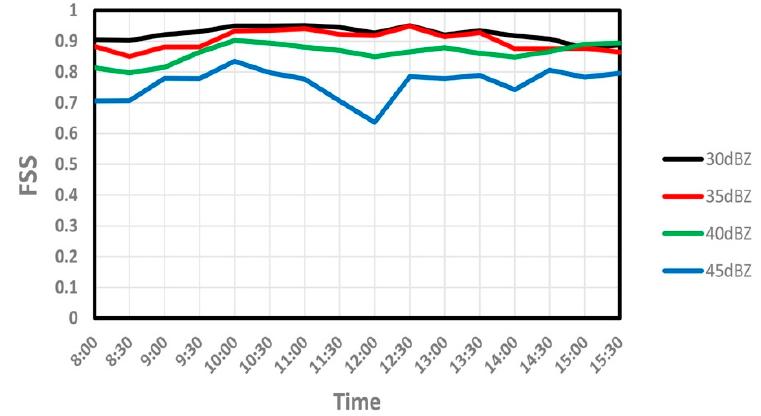
Figure 2. FSS of the simulated composite radar reflectivity for different thresholds.